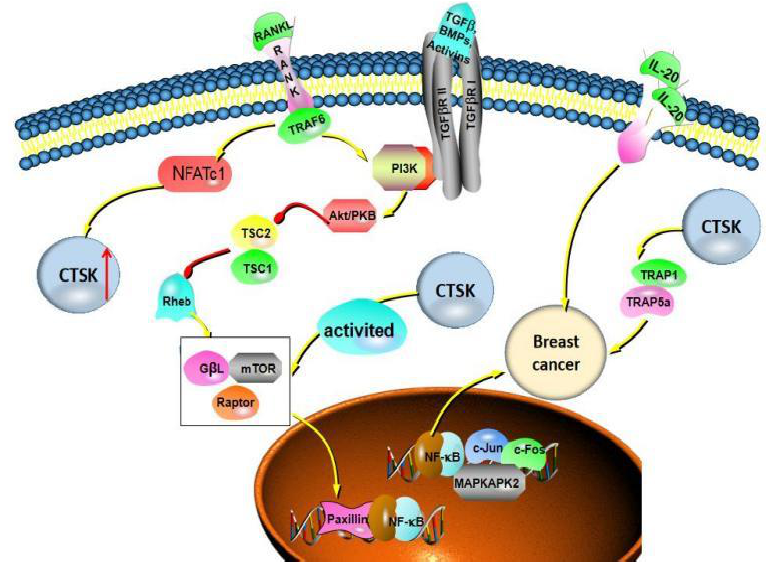
Figure 3. CTSK can promote the proliferation, invasion and migration of different types of breast cancer cells, especially bone metastasis. There are multiple signaling pathways involved in this process, including RANKL/RANK signaling, NF- κ B signal pathways, TGF- β and mTOR signal